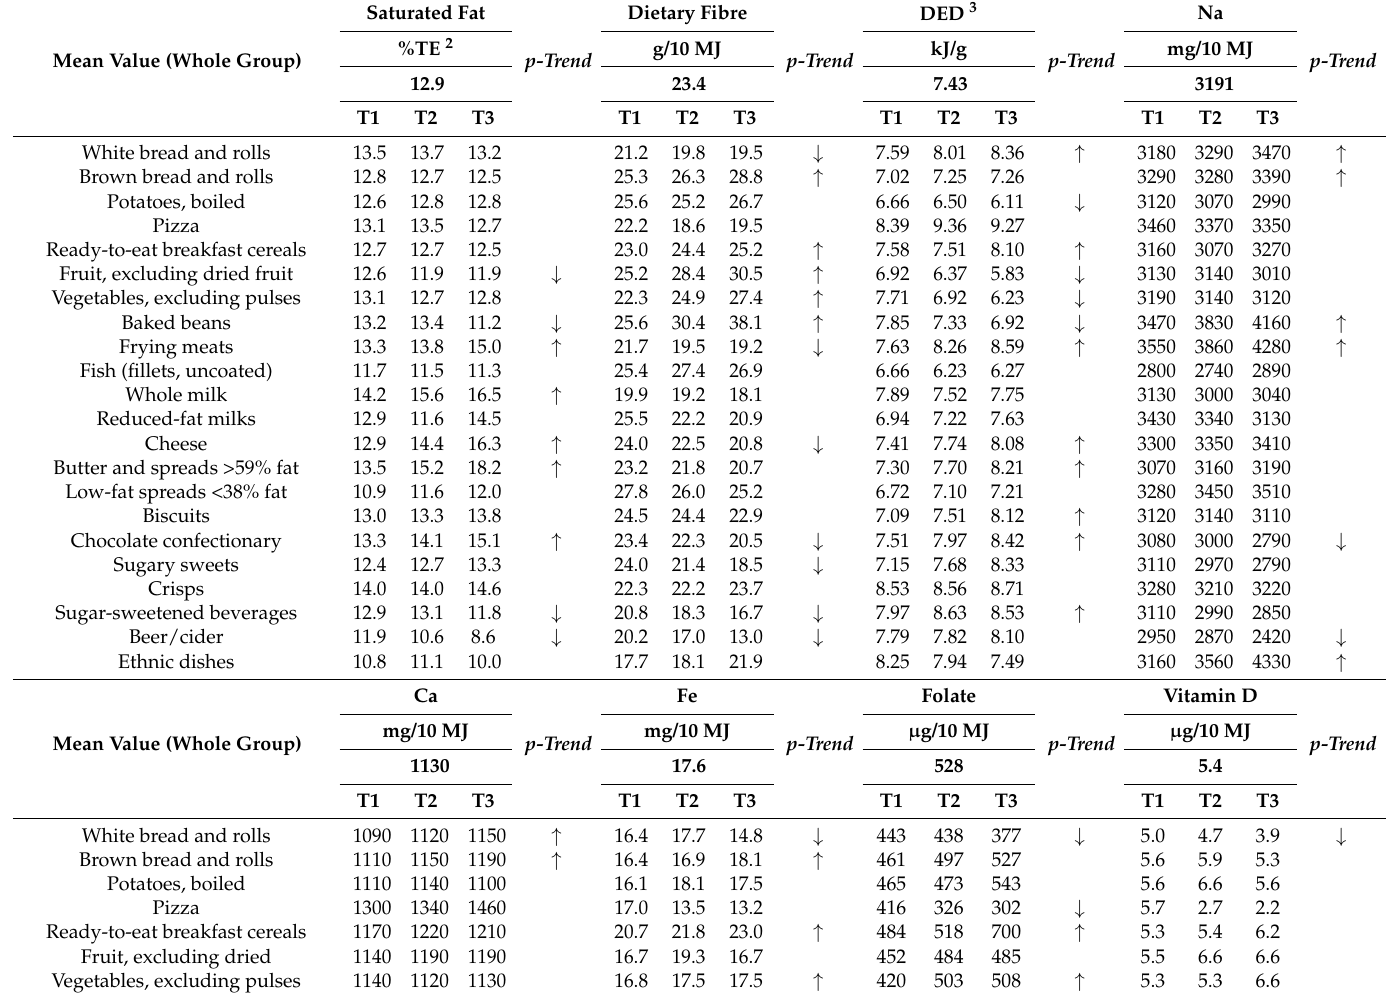
Table 3. Mean daily nutrient intakes by tertile of food portion size on the days the foods were consumed by a nationally representative sample of adults aged 18–64 years ( n = 1274), Republic of Ireland 1